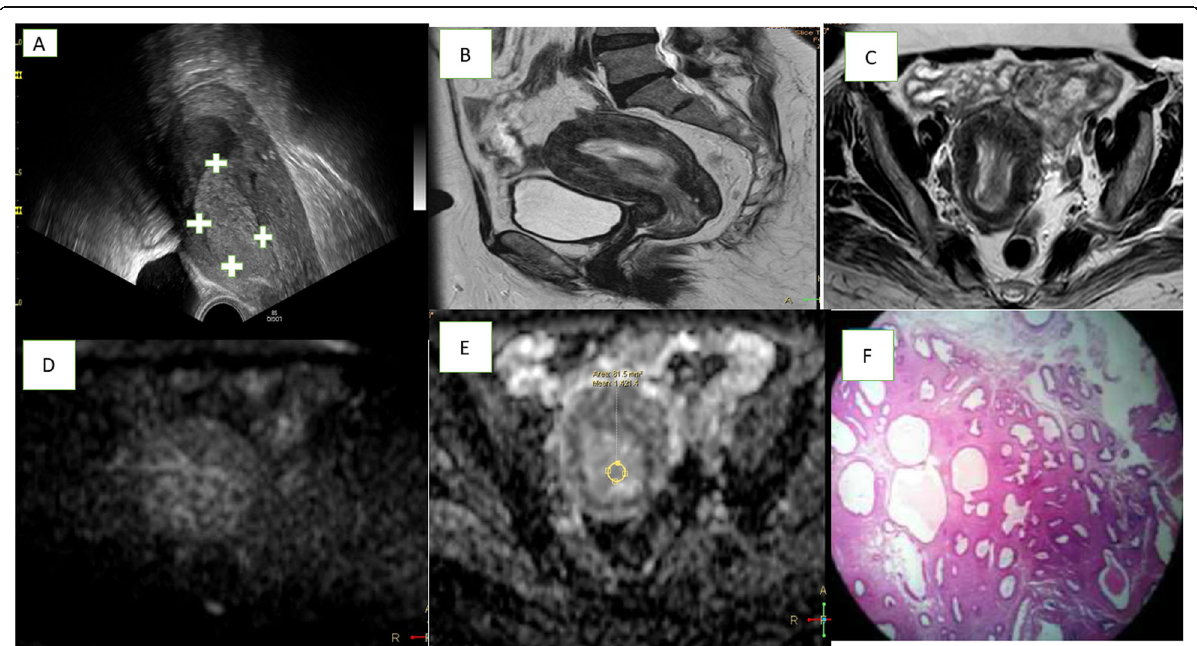
Fig. 2 Post-menopausal female aged 52 years old, presented with PMB. Sonohysterography image ( a ) showed a well-defined polypoidal hypoechoic soft tissue mass lesion with a smooth surface, and it was diagnosed as endometrial polyp by both observers. Sagittal T2 WI ( b ), coronal T2 WI ( c ), and axial T2WI ( d ) showed an endometrial polypoidal lesion of hypo-intense signal projecting from the uterine body into the cervical canal, no infiltration of the junctional zone or cervical canal. DWI at b 1000 s/mm 2 ( e ) showed low signal intensity. ADC map ( f ) ADC value measures about ± 1.421 × 10 -3 mm 2 /s ( g ). Microscopic image ( h ) confirmed endometrial hyperplastic polyp without